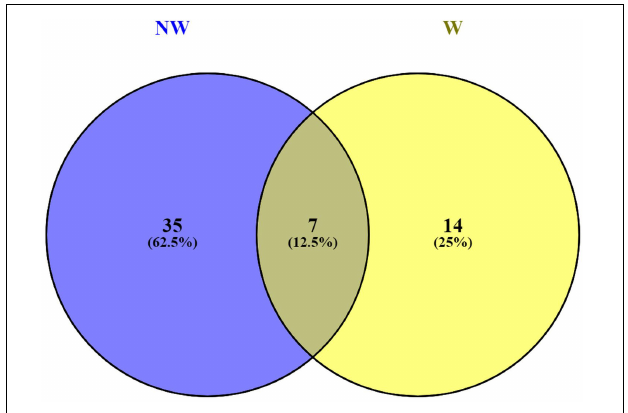
FIGURE 4 | Venn diagram for functional annotations shared by candidate genes associated with non-wounded (NW) and wounded (W) peach tolerance to brown rot